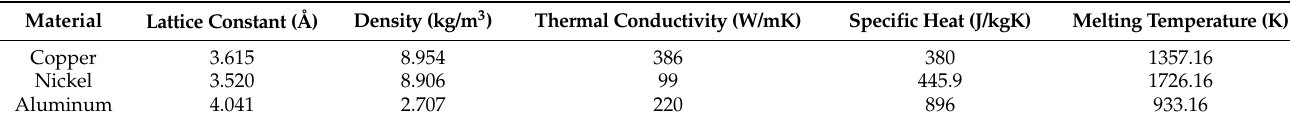
Table 1. Properties of materials used in the simulations [35].